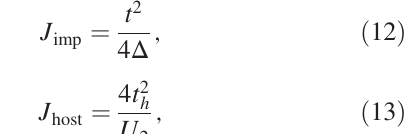
FIG. 4. Evolution of the spin exchange J doublon energy E , both given in Eq. (16) for increasing Hund ’ s D exchange η at the imp Fig. 4. We note that the dominant energy scale is E for a single 3 d − 4 d bond, the doublon will avoid occupy- ing the inactive ( γ ) orbital and the spins will couple with γ Þ J ð D ð ¼ 0 Þ , which can be either AF if η S j